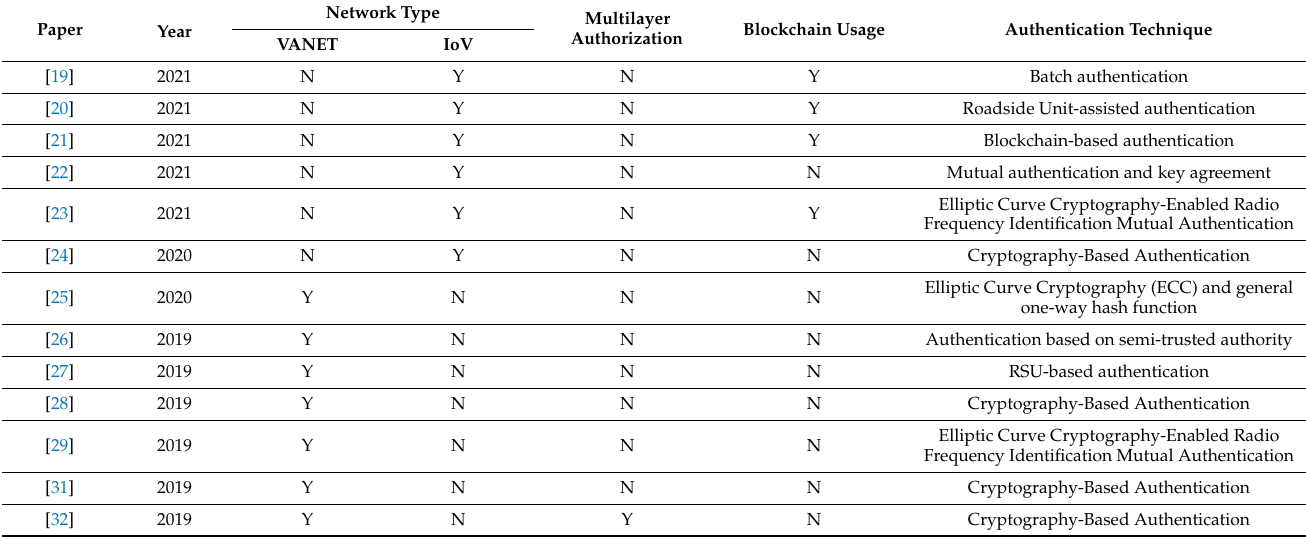
Table 1. Related Work in Authentication of IoVs and